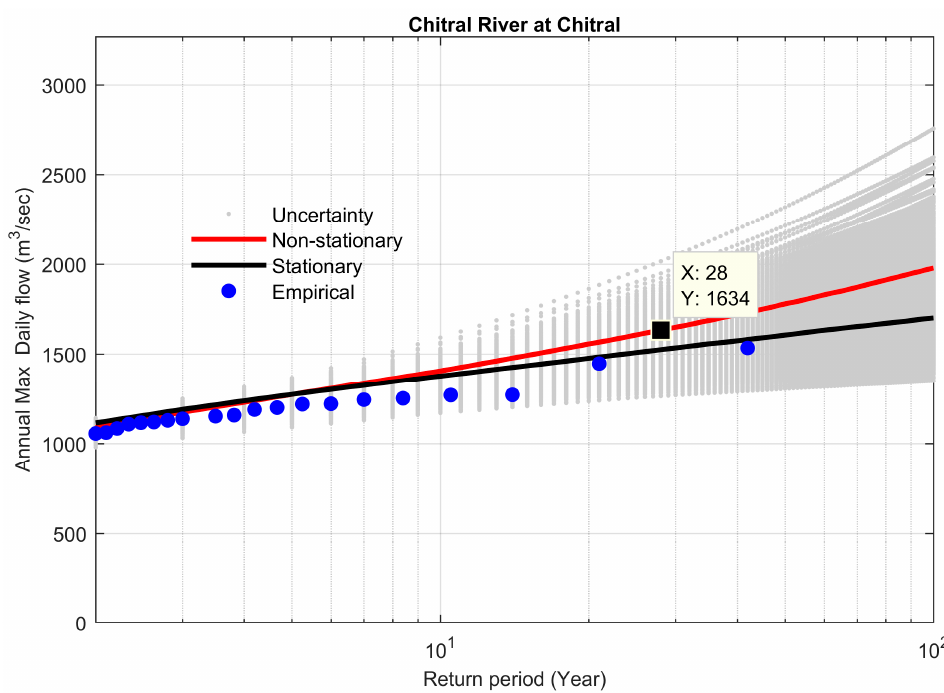
Figure 14. Comparison between non-stationary and stationary FFCs at site 6, along with non-stationary uncertainty bounds for the year 2004.